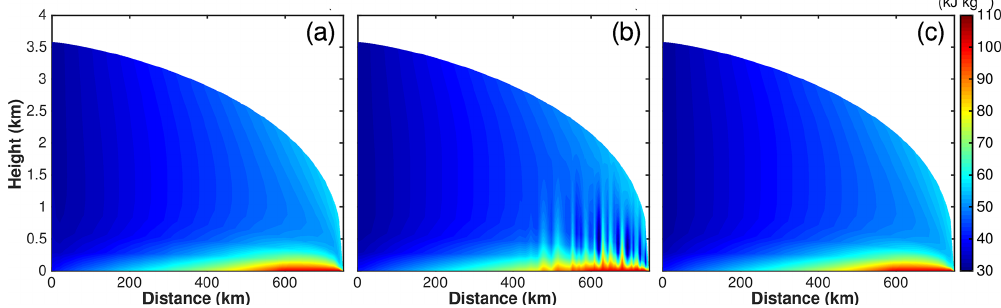
Figure 5. Simulated enthalpy (kJkg − 1 ) for the ice dome experiment with l min = 10km and k 2 = 50am − 1 along a vertical cross section. (a) SUPG maxK, (b) SUPG minK, and (c) ASUPG. The location of the cross section is shown in Fig.